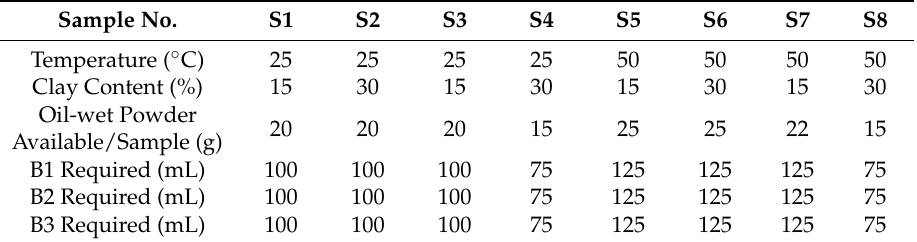
Table 4. Quantity of sample and each brine required for the tests.